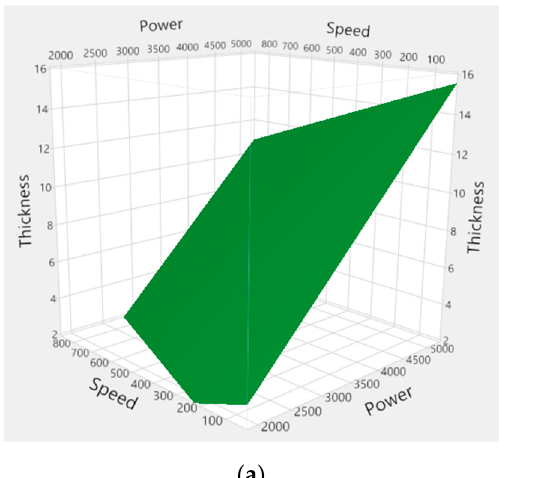
Table 1. Factor levels for design and welding parameters.